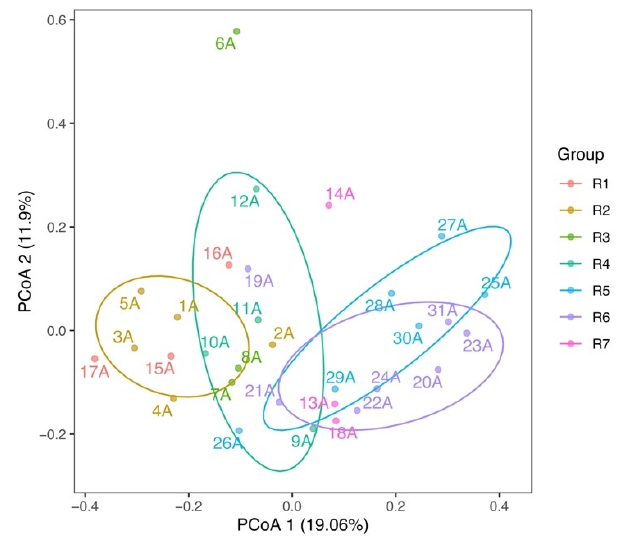
Figure 4. Principal coordinate analysis (PCoA) showing microbial composition differences among different reaches. Only ellipse with points in each reach greater than 3 are shown.